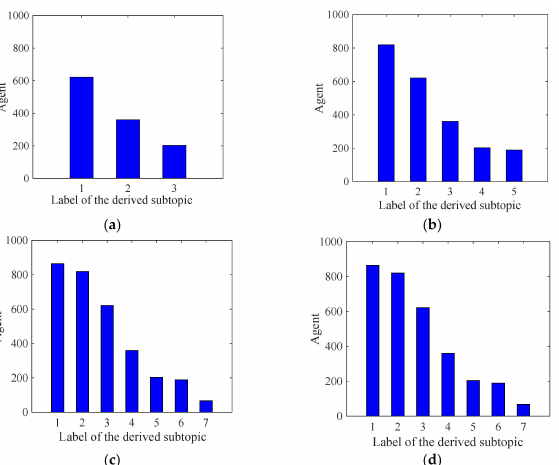
Figure 14. The number of agents participating in subtopic communication under different environ- mental forces. ( a ) δ = 3. ( b ) δ = 5. ( c ) δ = 7. ( d ) δ =